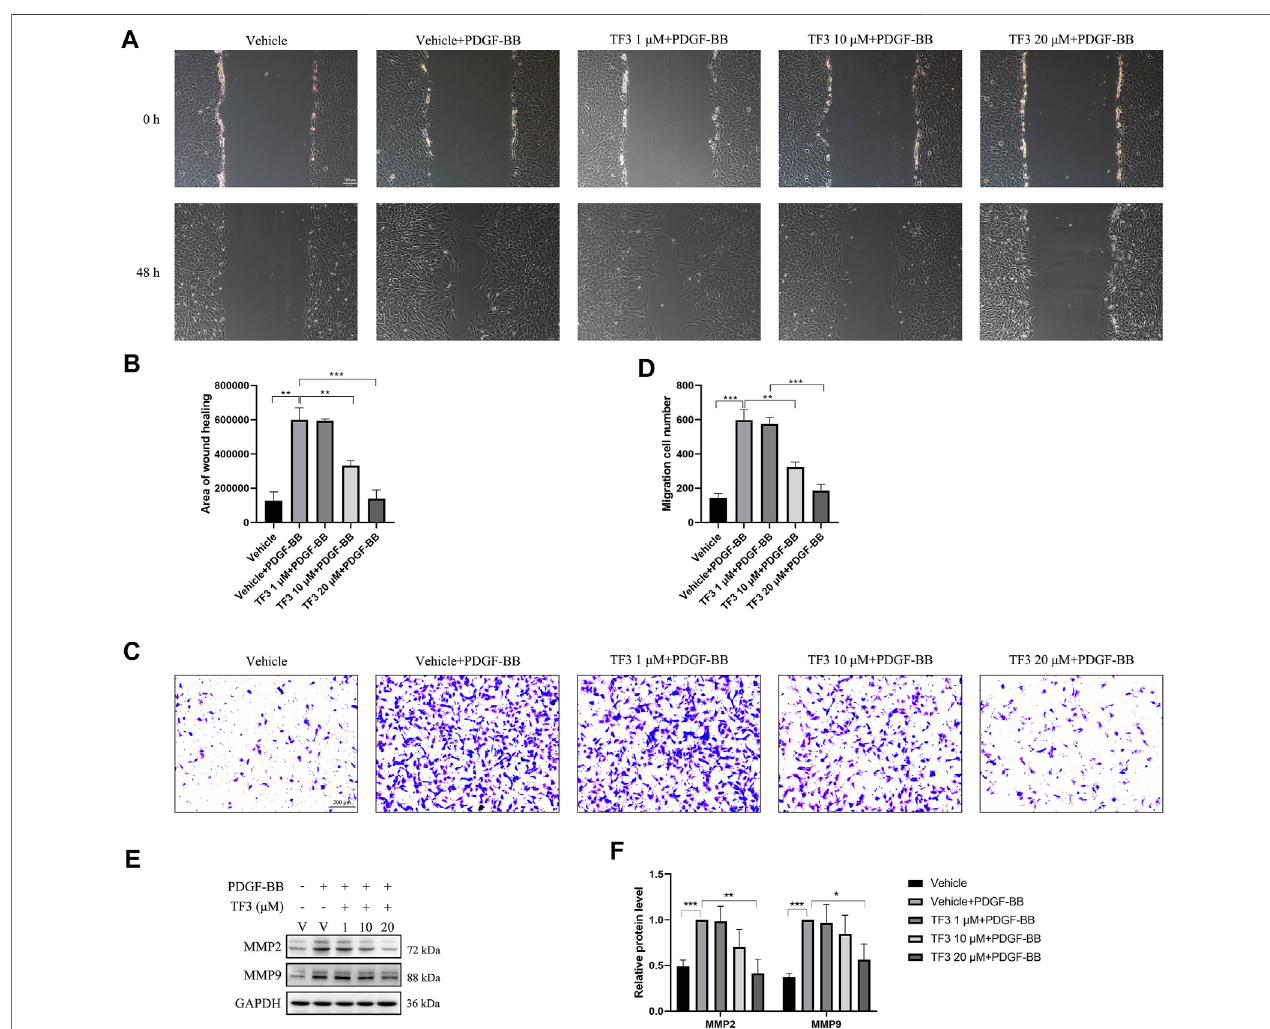
FIGURE 5 | Effects of thea fl avin-3,3 ′ -digallate (TF3) on PDGF-BB – induced migration in rat aortic smooth cells (RASMCs). Serum-starved RASMCs were pretreated with 1-, 10-, or 20- μ M TF3 for 1 h and then stimulated with 20 ng/ml PDGF-BB for 48h. (A) The wound healing migration assay wasperformed as indicated. Scale bar, 100 μ m (B) The statistical data of the wound healing assay are shown. (C) The transwell assay was performed as indicated. Scale bar, 200 μ m (D) The statistical data of the transwell assay are shown. (E) The levels of the cell migration-associated proteins MMP2 and MMP9 were detected by western blot. (F) The statistical data of the western blot analysis are shown. Each experiment was performed in triplicate. * p < 0.05, ** p < 0.01, *** p < 0.001.